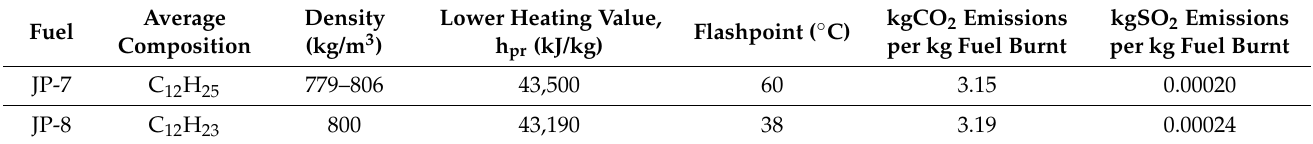
Table 2. Carbon intensity of hydrocarbon